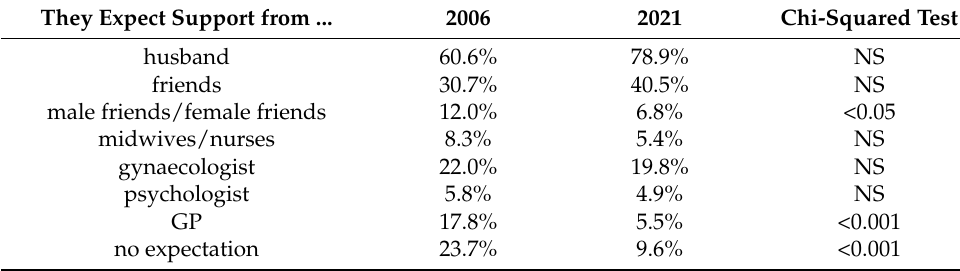
Table 5. The list of persons from whom climacteric women expect support. They Expect Support from